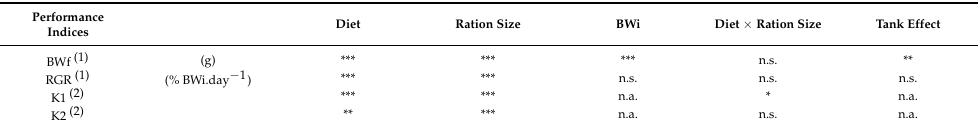
Table 4. Statistical significance ( p -values) of diet, ration size and their interaction, and of initial body-weight and tank effects for each growth parameter determined based on type III sum of squares from factorial ANOVA. When nested ANOVA were applied, ration size and treatment effects were systematically tested from a test of hypothesis using the tank random effect as the error term. (n.s., not significant; * p < 0.05; ** p < 0.01; *** p <